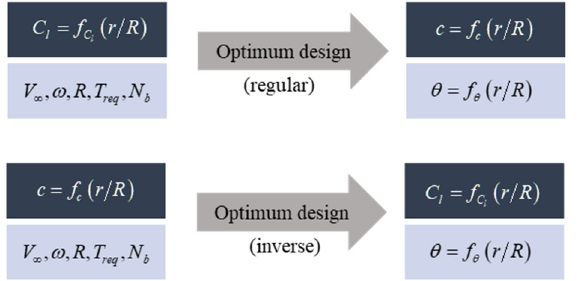
Figure 11. Regular and inverse design methods based on Betz optimal theory.